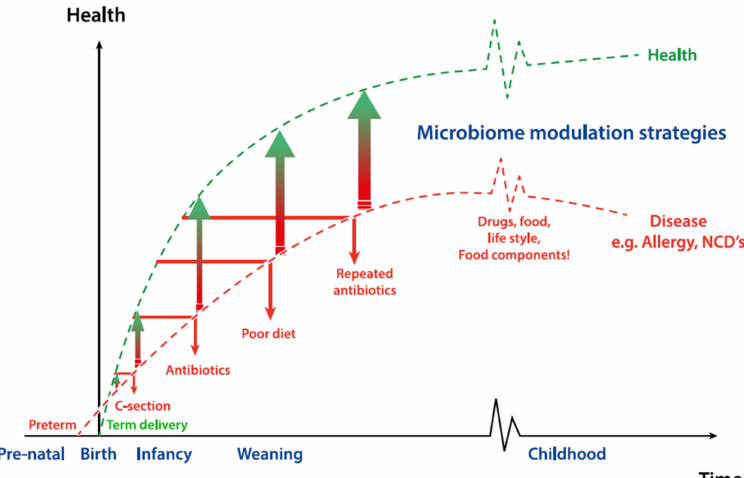
Figure 2. Impact of microbiome (including Bifidobacterium spp.) modulation strategies on early life